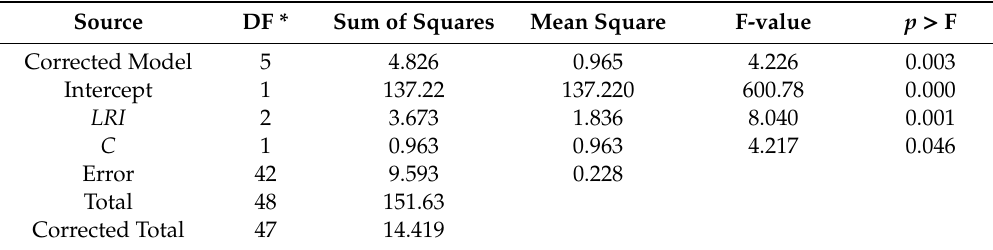
Table 12. Outcome of the last iteration for the ANOVA over Ln Rz